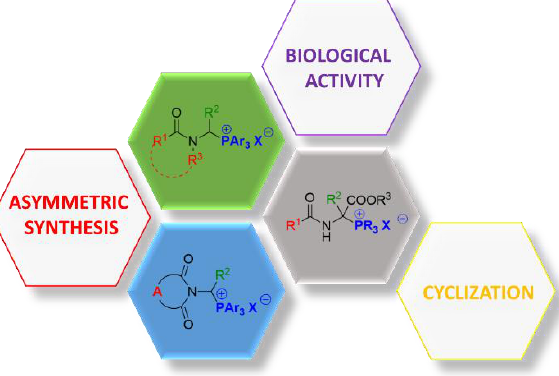
Figure 8. 1-Aminoalkylphosphonium derivatives — new challenges.